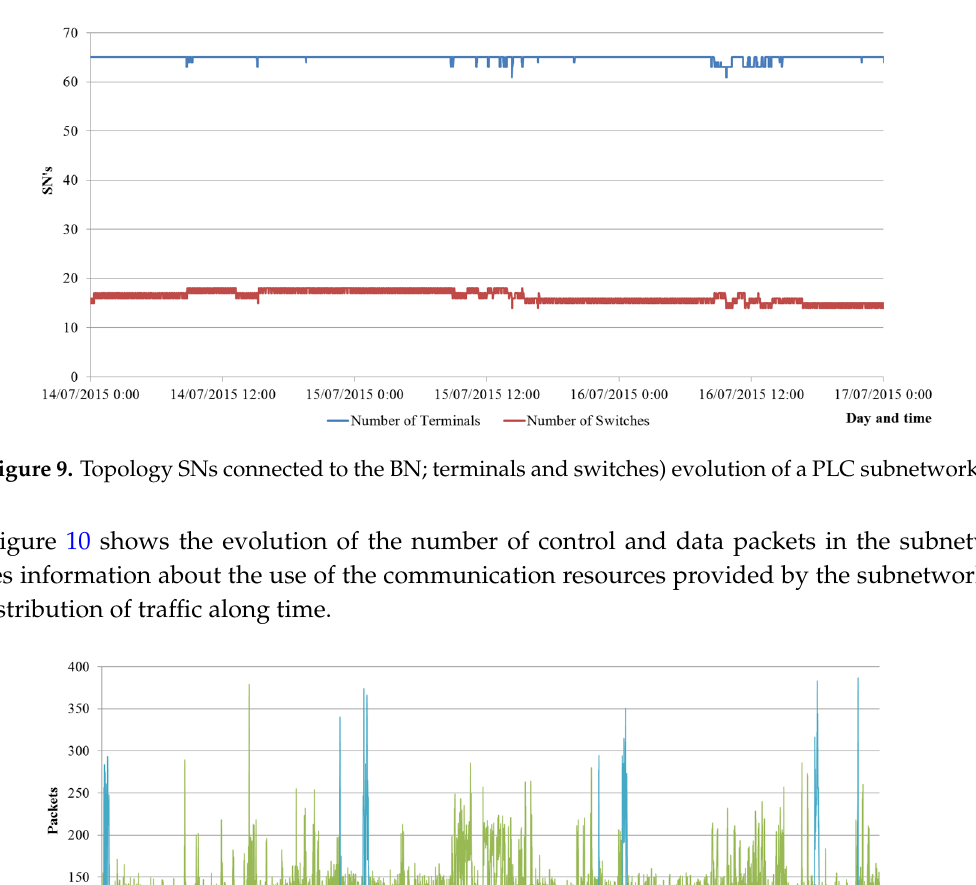
Figure 11. PLC channel occupation in a subnetwork.